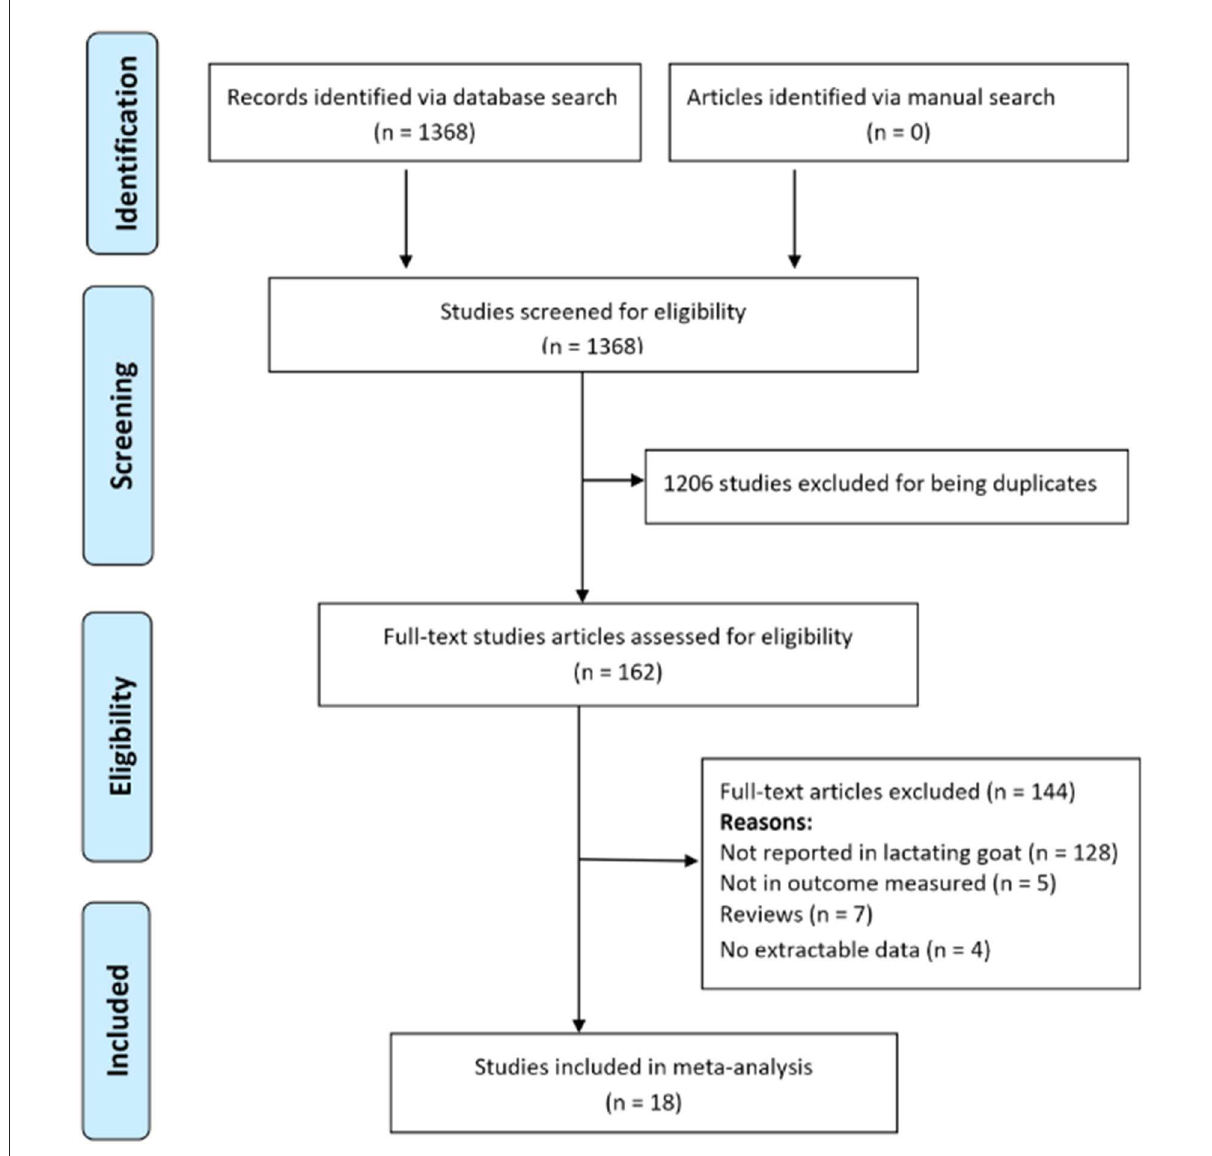
FIGURE1 Flow chart of article selection process used for the meta-analysis.